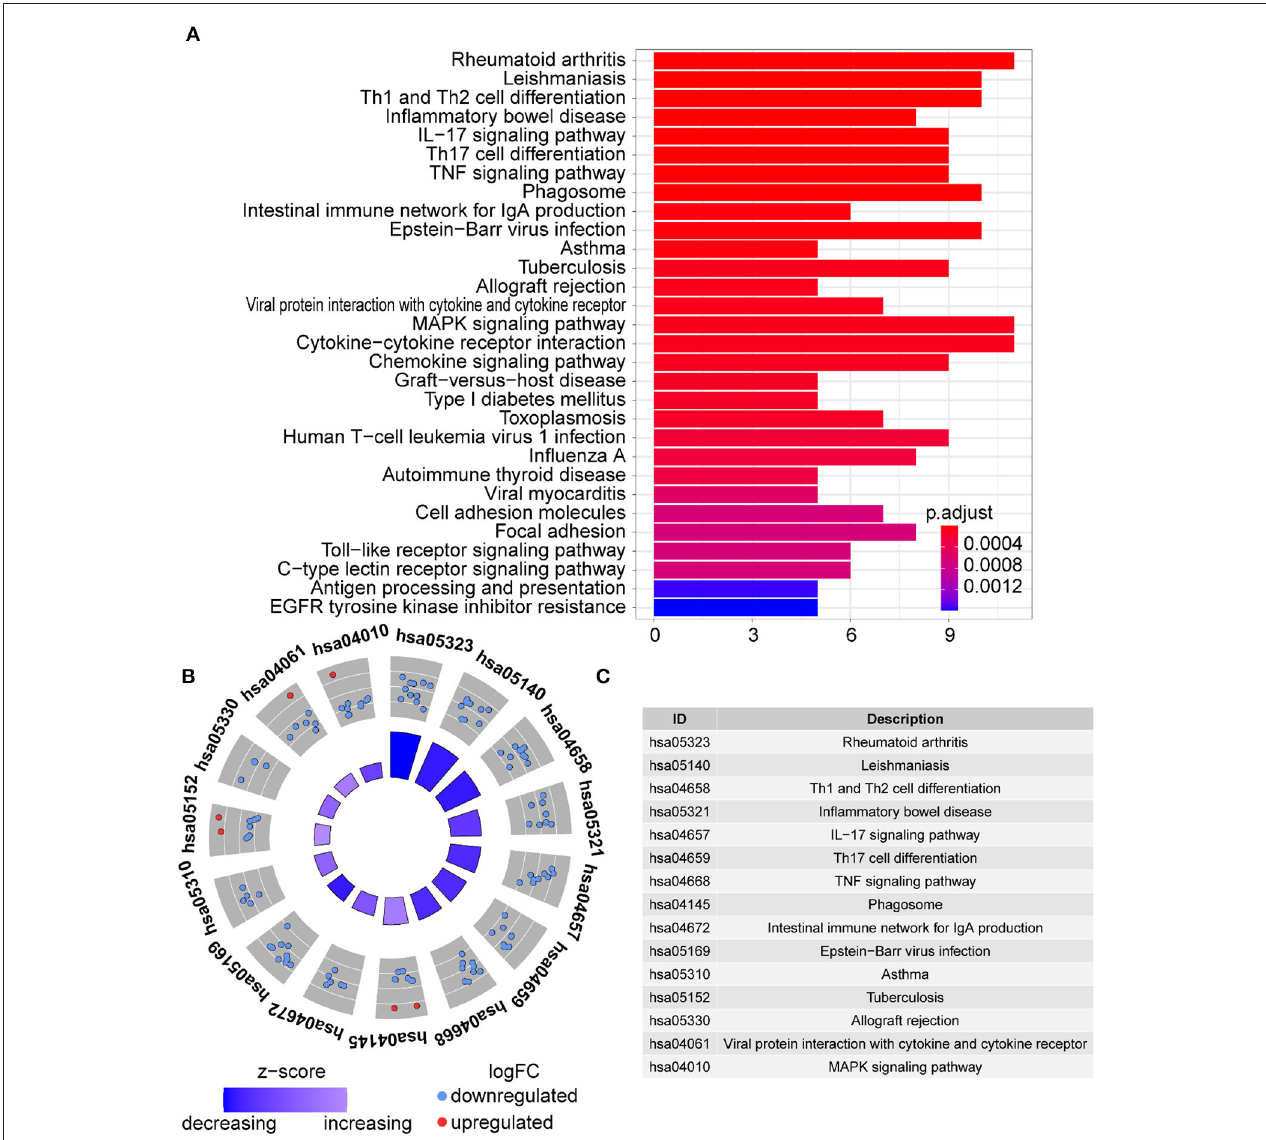
FIGURE 11 | KEGG analysis of the DE-IGs between inflamed and fibrotic livers of BA. (A) The 30 most significantly enriched KEGG pathways are displayed in the barplot. The length of the bar represents the number of genes enriched and the color represents the correlation. (B) The circle of KEGG enrichment analysis. Each dot in the circle represents a gene, and the outer circle reflects the enrichment of the DE-IGs in different signaling pathways. The inner-circle represents the Z-score, the color depth corresponding to the Z-score. Higher Z-score indicates a higher expression of the DE-IGs in enriched pathways. (C) The table annotates KEGG